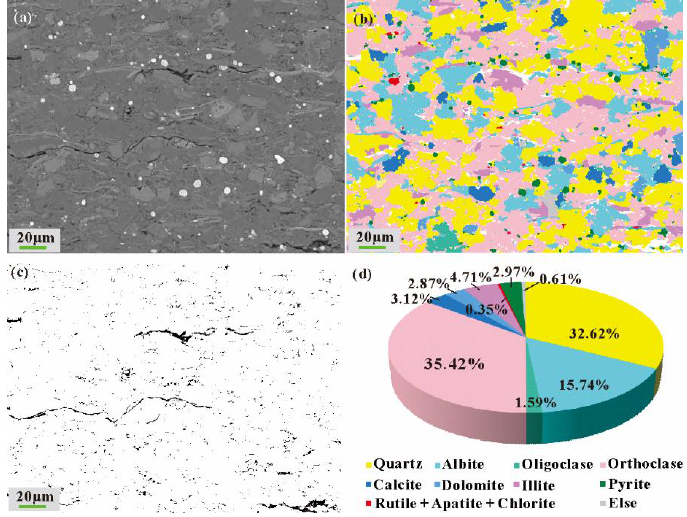
Figure 3. ( a ) Backscattered electron (BSE) image; ( b ) Mineral composition analysis; ( c )